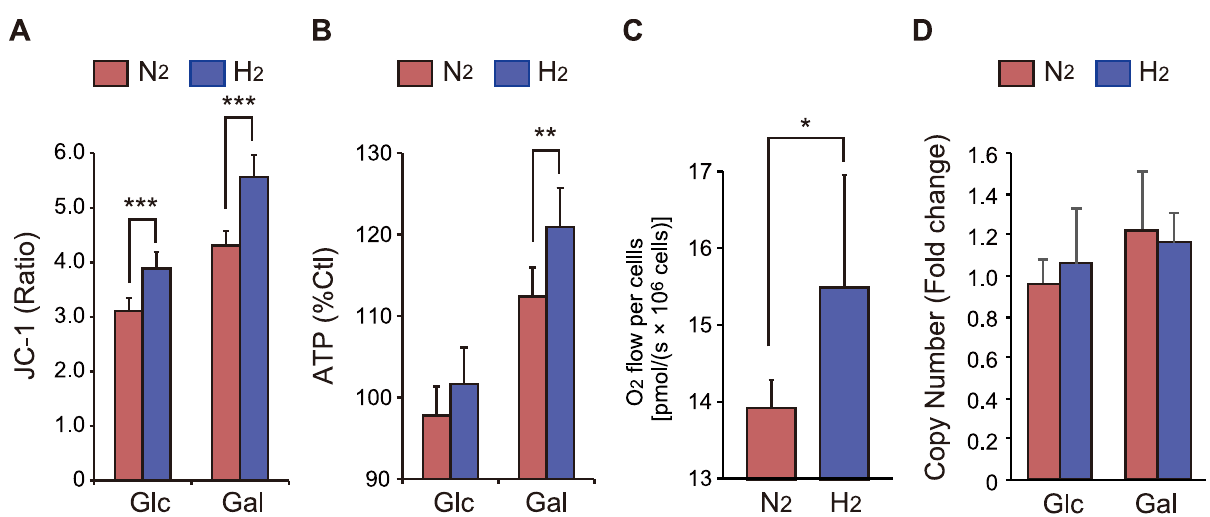
Fig 3. Enhancement of mitochondrial activities by H 2 treatment. (A) H 2 treatment enhanced JC-1-indicated ΔΨ m , which was expressed as the ratio of monomersto aggregates.(B) H 2 treatment enhancedthe accumulationof ATP, which was expressedas a percentage compared with cells not treated with mixed gases (consideredas 100%). SH-SY5Y cells were incubatedin culture medium containing either Glc or Gal under N 2 - or H 2 -mixed gas for 18 h. ** P < 0.01, *** P < 0.001 (A, B). (C) H 2 treatment enhanced the O 2 consumption rate in state 3. O 2 consumptionwas monitored with high-resolution respirometry. * P < 0.05. (D) The mtDNA copy number relativeto nDNA in cells incubatedunder